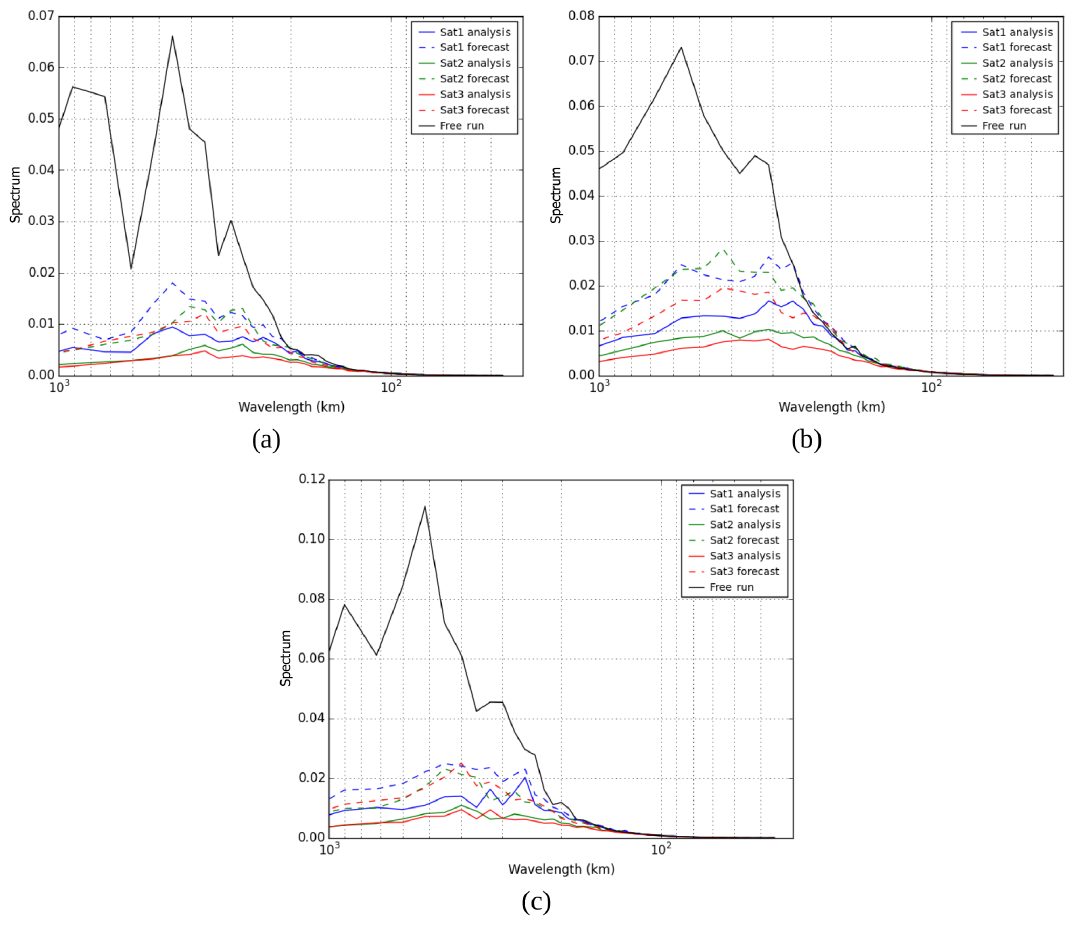
Figure 11. Sea level variance preserving error spectrum in the GS (a) , AC (b) and KU (c) for FR (black), Sat1 (blue), Sat2 (green) and Sat3 (red). Analyses are shown with solid lines and 7-day forecasts with dashed